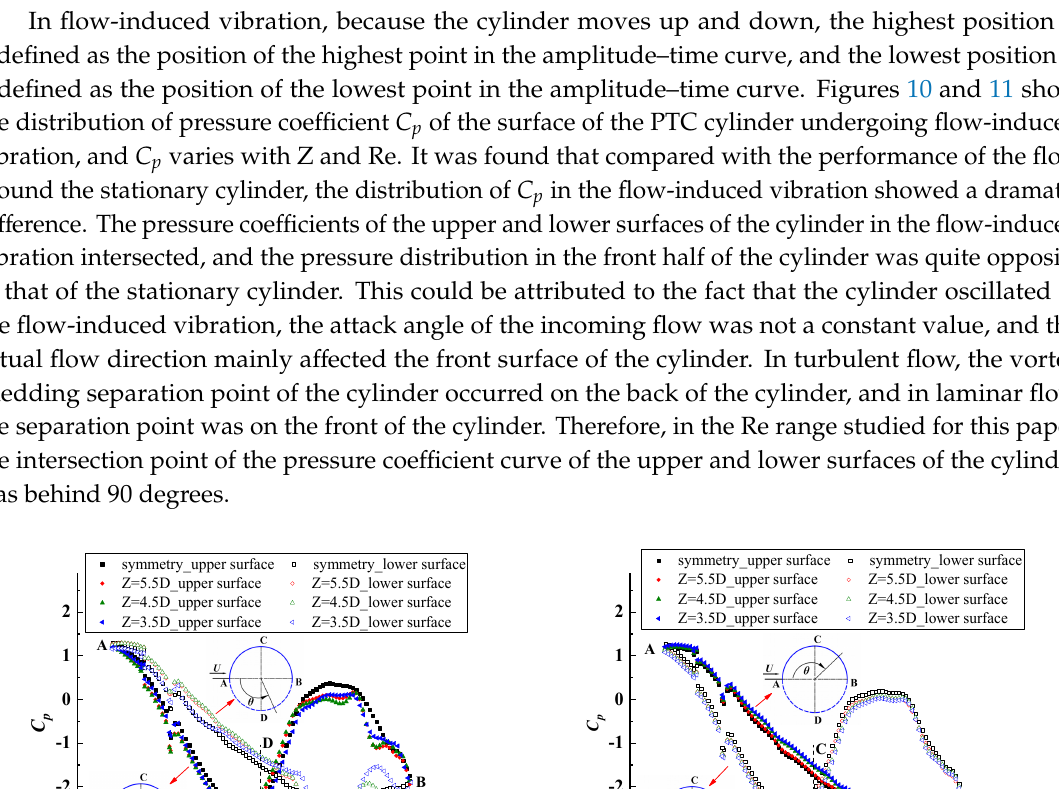
Figure 9. The C p of the stationary PTC cylinder varied with the Reynolds number (Z = 5.5 D ).